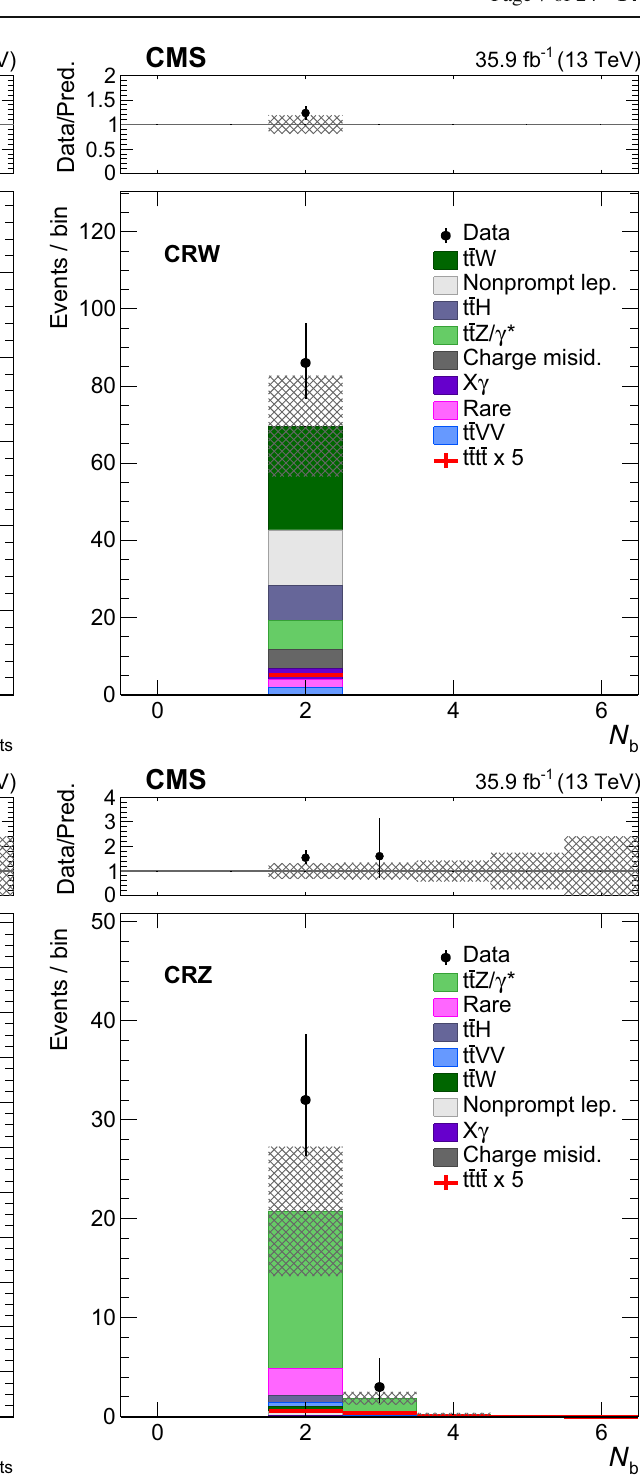
section from Ref. [17]. The upper panels show the ratios of the observed event yield to the total background prediction. Bins without a data